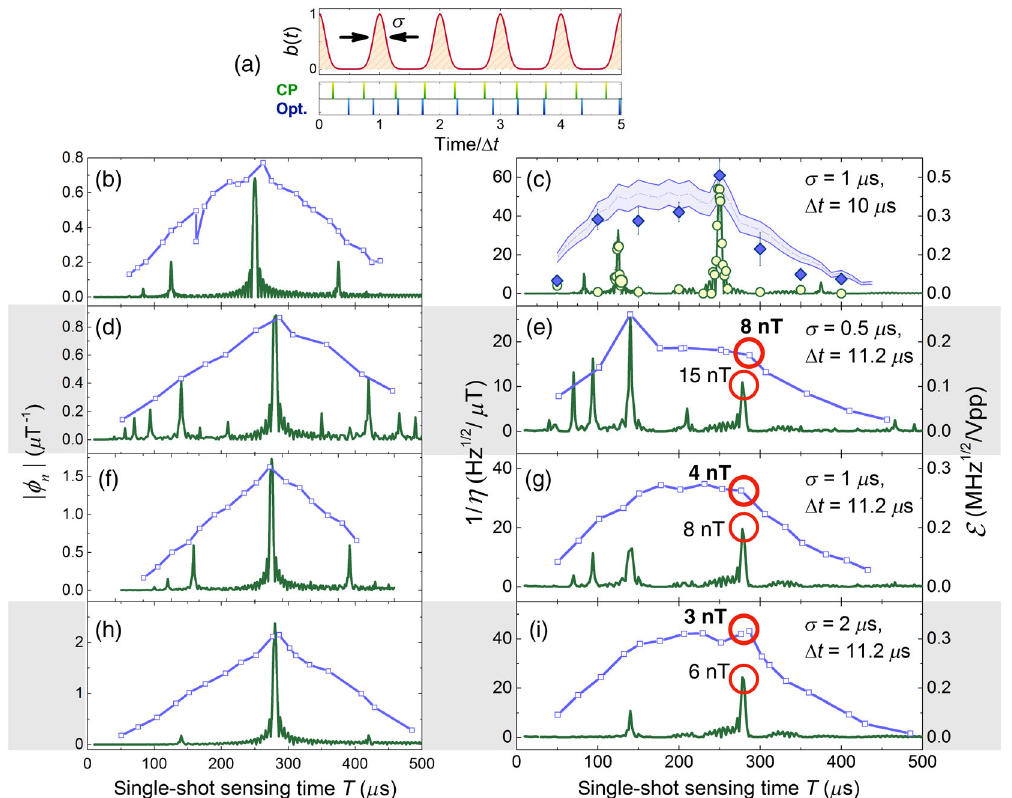
FIG. 4. Optimal sensing of Gaussian impulses. (a) Upper panel: Target signal made of a train of Gaussian impulses of width σ and repetition rate 1 = Δ t . Bottom panel: Position of the first 10 pulses of a CP- 50 , with total sensing time T ¼ 280 μ s optimized to sense a train of Gaussian impulses with σ ¼ 2 μ s, Δ t ¼ 11 . 2 μ s (in green), and optimal position of the first 10 pulses of a control sequence of 50 pulses (in blue), optimized to sense the same targetfield (50 optimization parameters). (b) – (i) Modulus of the phase accumulated bythe spin qubit sensor in the presence of the target field (left panels), and the inverse of sensitivity 1 = η (right panels), as a function of the sensing time T , under CP- 50 control (green solid curves) and under optimized control (blue lines with squares) with bounds τ ∈ ð 0 . 6 – 10 Þ μ s (see Appendix A 3). (c) Measurement of the experimental observable E as resulting from CP experiments (yellow dots) and from optimized control (blue diamonds), scaling as indicated on the right-hand side, vertical axis. The target field parameters of panels (b) – (i) are as follows: (b,c) σ ¼ 1 . 0 μ s, Δ t ¼ 10 μ s; (d,e) σ ¼ 0 . 5 μ s, Δ t ¼ 11 . 2 μ s; (f,g) σ ¼ 1 . 0 μ s, Δ t ¼ 11 . 2 μ s; (h,i) σ ¼ 2 . 0 μ s, Δ t ¼ 11 . 2 μ